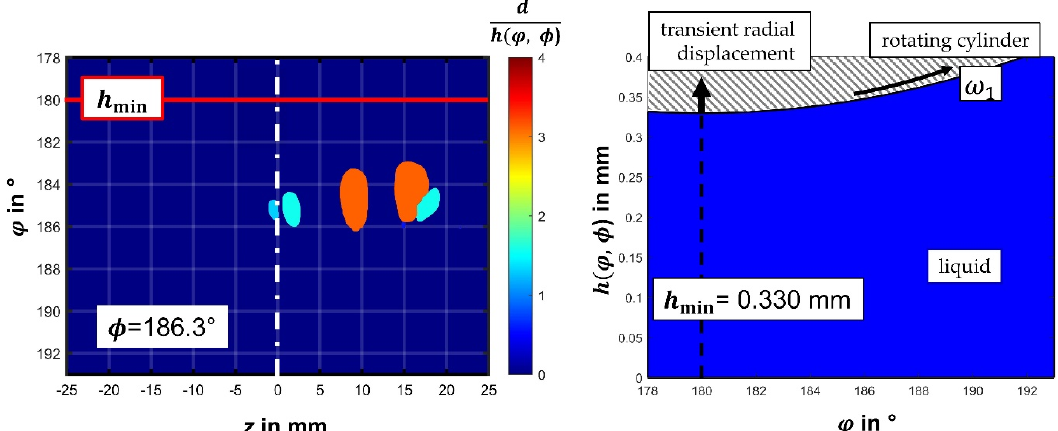
Figure 9. Bubble size in relation to local film thickness during phase 2, rotational angle φ = 185.0 ◦ after initiation of transient radial displacement, simultaneous gas and pseudo-cavitation, fluid: paraffin containing 100% dissolved air.